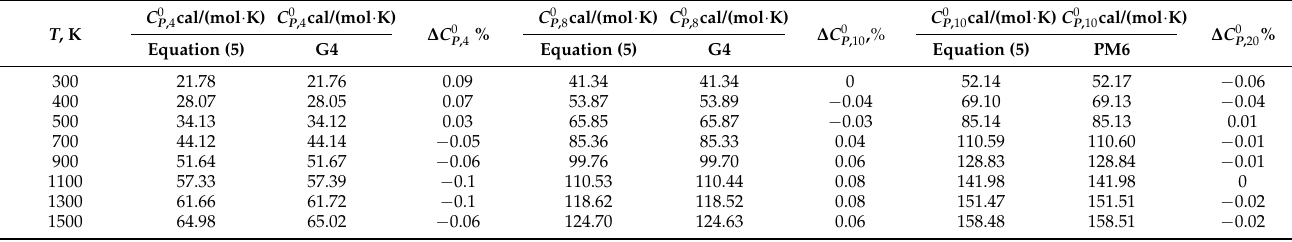
( T ) of n -C 4 H 10 , n -C 8 H 18 , n -C 10 H 22 [12]. P